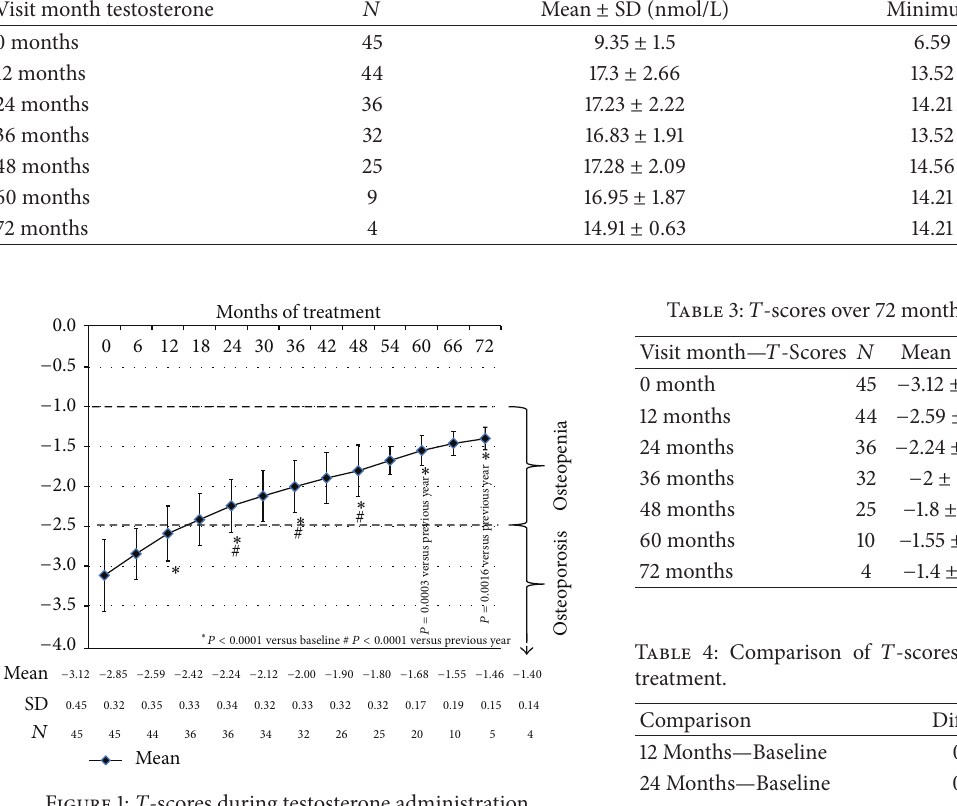
Figure 1: T -scores during testosterone administration.